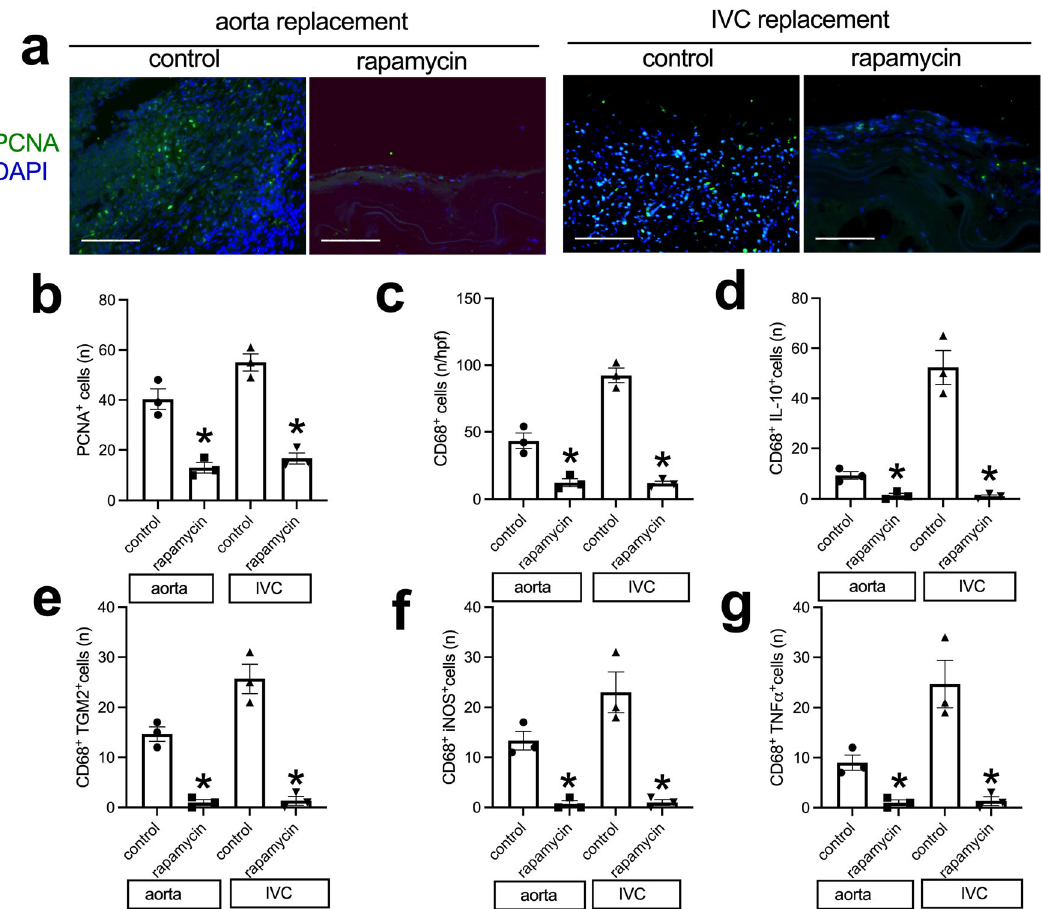
Photograph of the immuno fl uorescence merged of PCNA (green) and DAPI (blue) of the neointima in the tube graft; scale bar, 100 μ m; n = 3. b Bar